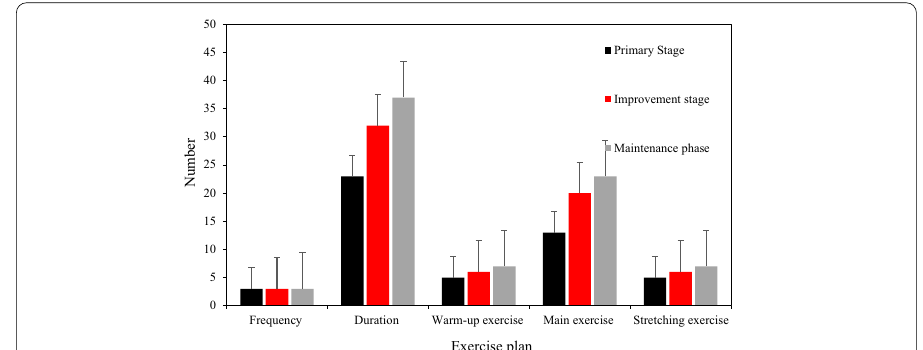
Fig. 10 Healthy physical fitness track and field teaching exercise plan